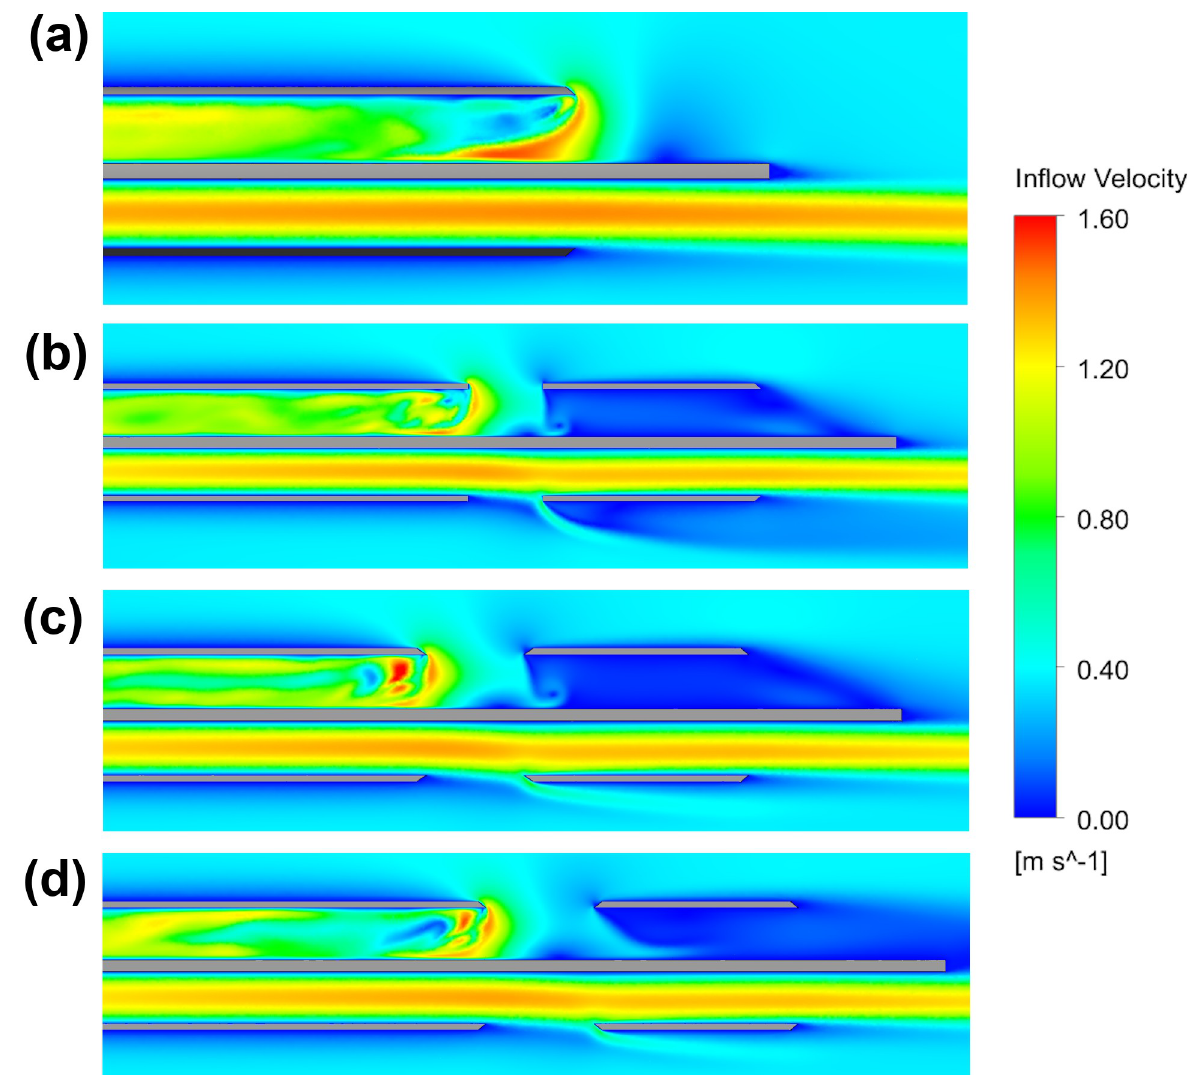
Fig 6. Velocity contours for the no-hole (a), Medium circular (b), Medium Oval (c) and Large oval (d).